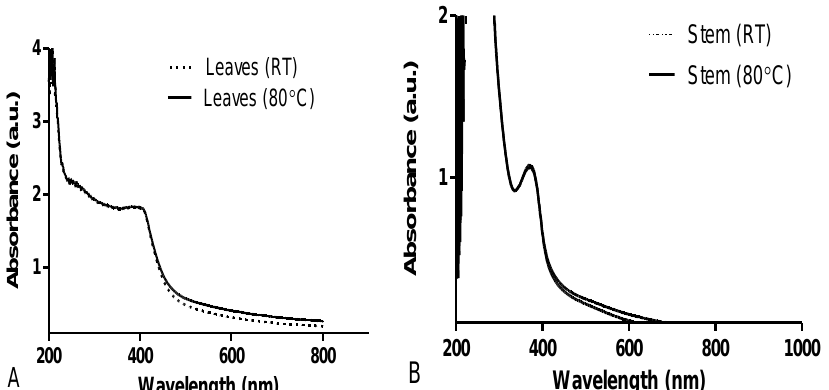
Fig. 2b: UV- visible spectra of AgNPs synthesized Fig. 2a: UV- visible spectra of AgNPs synthesized from Figure 2. UV-visible spectra of D. villosa leaves ( A ) and stem ( B ) AgNPs at room temperature (RT) Figure 2. UV-visible spectra of D. villosa leaves ( A ) and stem ( B ) AgNPs at room temperature (RT) from D. villosa stem at room temperature and at 80  C D. villosa leaves at room temperature and at 80  C and at 80 °C. and at 80 ◦